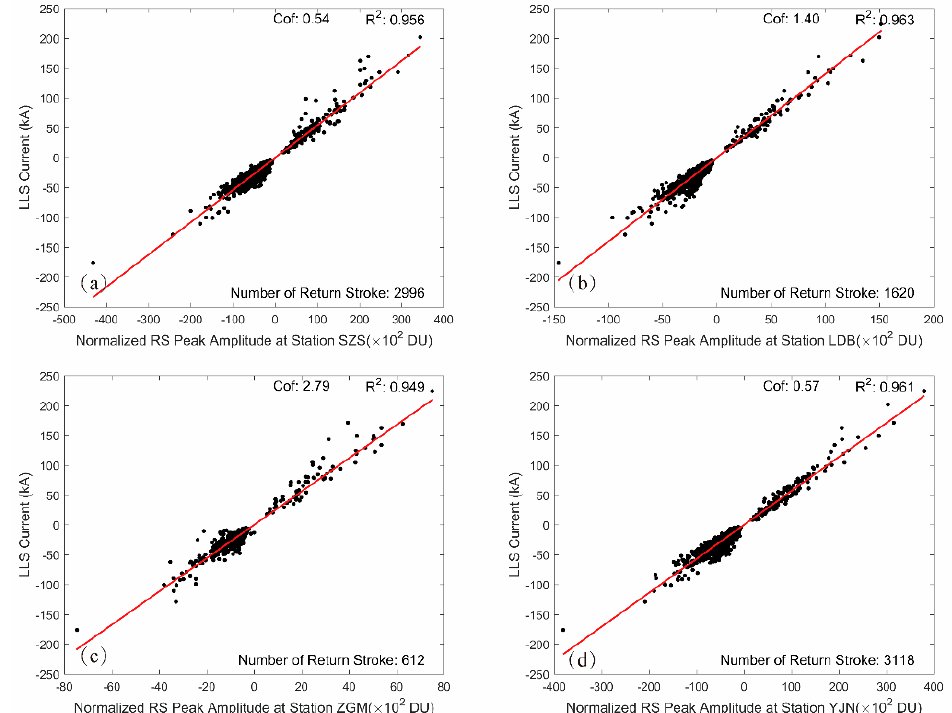
Figure 4. The LLS currents versus the normalized RS peak amplitude at FALMA station SZS ( a ); LDB ( b ); ZGM ( c ); and YJN ( d ). The red lines represent the fitted curves. The fitting goodness and the conversion coefficients between the normalized RS peak magnitudes and RS peak currents are marked on the upper right corner of each subplot.